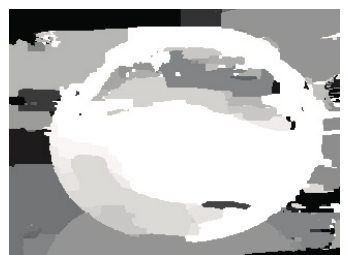
Figure 13. First stage depth